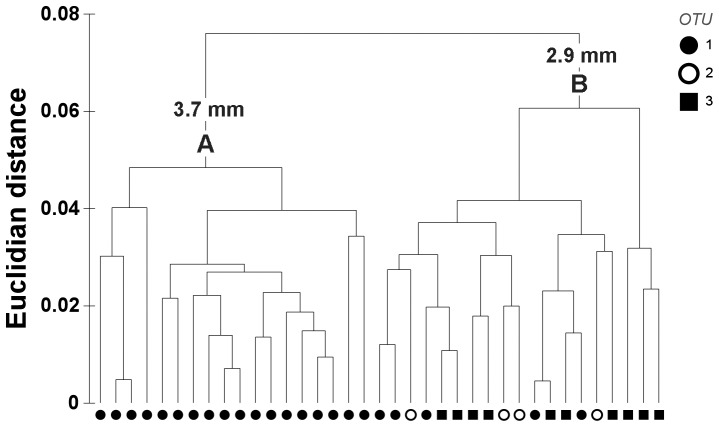
Cluster analysis of shell outlines (Elliptical Fourier Analysis).The analysis is based on the first 10 harmonics. Shells form two groups, A and B, which differ significantly in length (indicated above the groups) based on a t-test (p<0.01). Symbols refer to operational taxonomic groups (OTUs) based on CO1, 18S and 28S rRNA sequences.